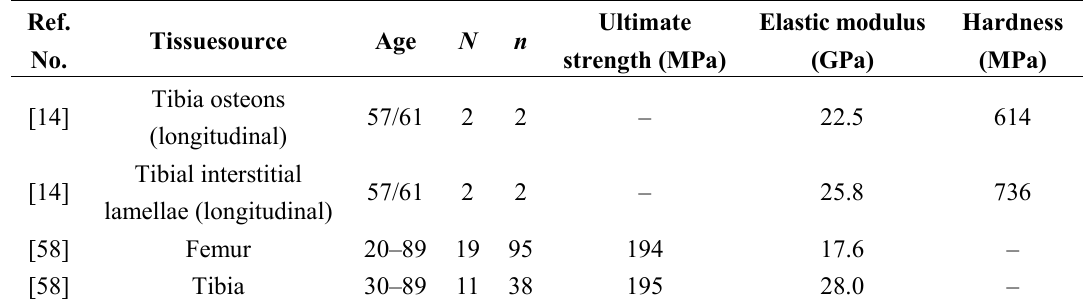
Table 2. Compressive properties of human cortical bone. ( N being the number of bones tested and n , the number of machined specimens obtained from them). Ref.